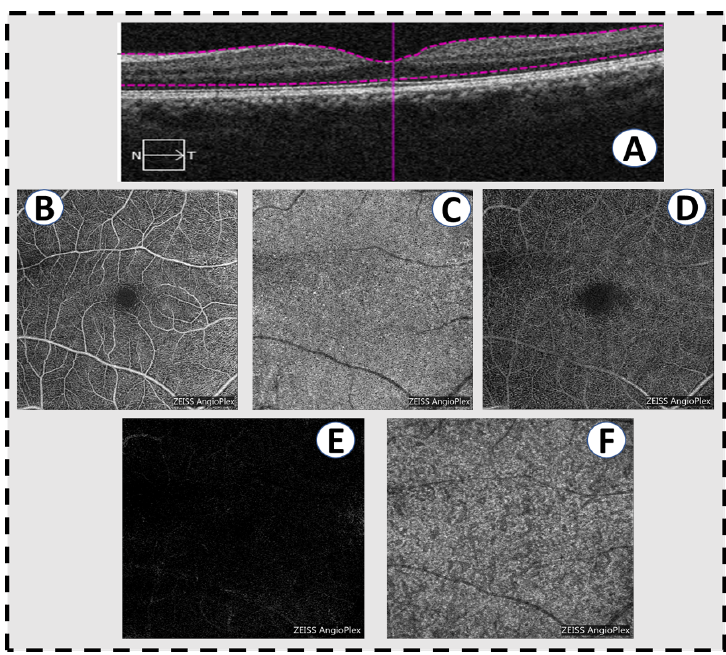
Figure 5. Optical coherence tomography angiography scans in a normal patient. ( A ) A horizontal slice of a conventional OCT scan showing normal macular anatomy. ( B ) The superficial vascular plexus of the inner retina. ( C ) The choriocapillaris. ( D ) The deep vascular plexus of the middle retina. ( E ) The outer retina is avascular, hence the absence of retinal vessels in a normal eye. ( F ) The deeper choroid.